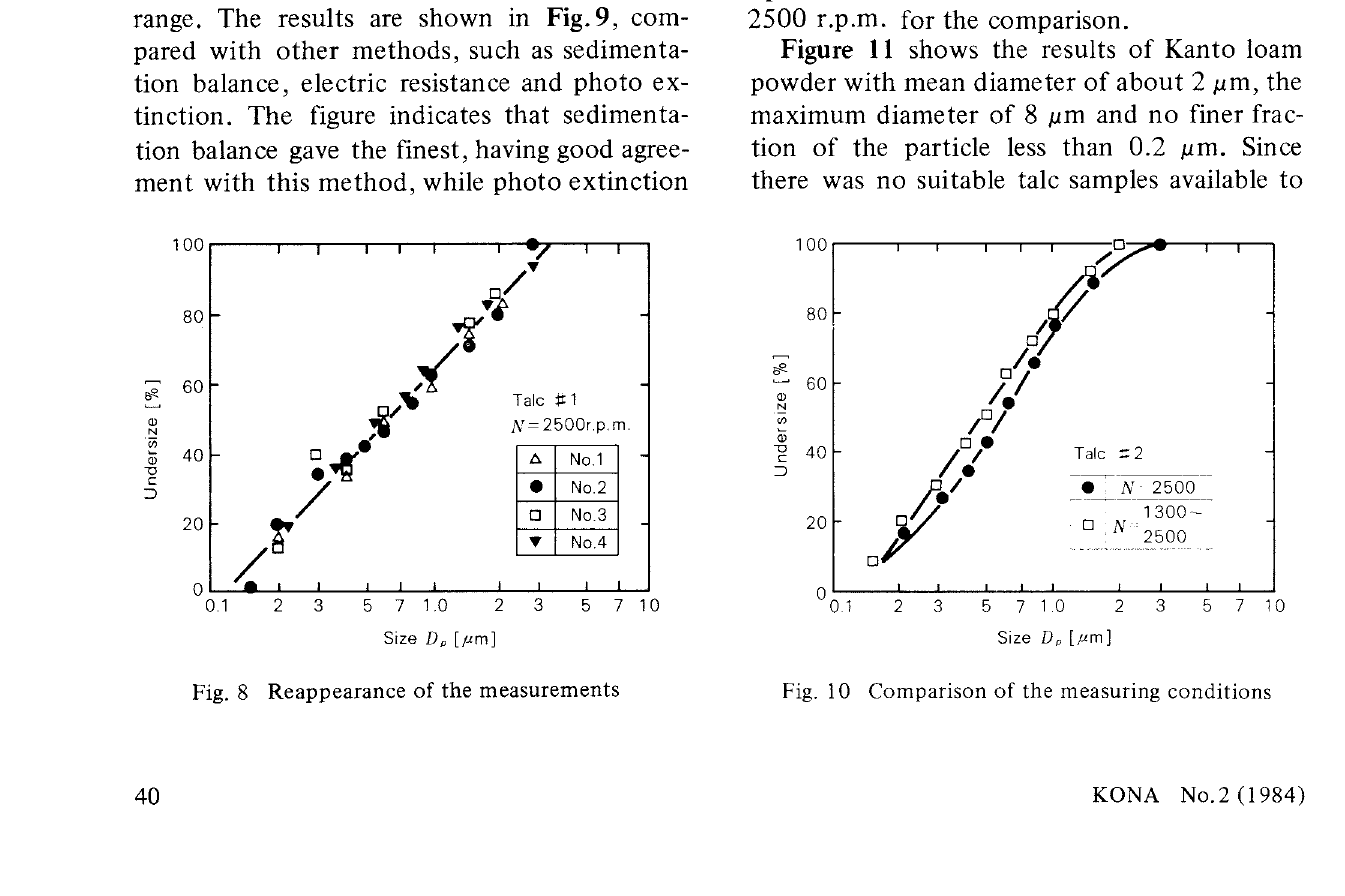
Fig. 8 Reappearance of the measurements